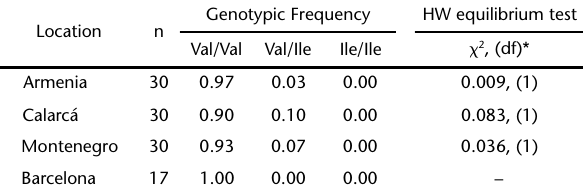
Table II. Genotypic frequency of the mutation Val1016Ile in the NaV of four Aedes aegypti populations from Quindío, Colombia. Location n